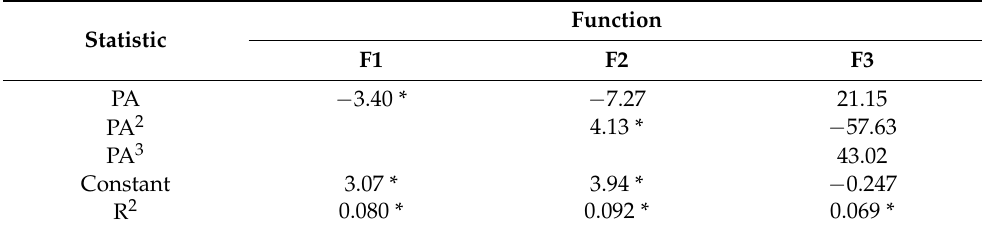
Table 2. Regression results for the entire sample (boys and girls) ( p -value for R 2 ). Function Statistic F1 F2 F3 PA − 3.40 * − 7.27 21.15 PA 2 4.13 * − 57.63 PA 3 43.02 Constant 3.07 * 3.94 * − 0.247 R 2 0.080 * 0.069